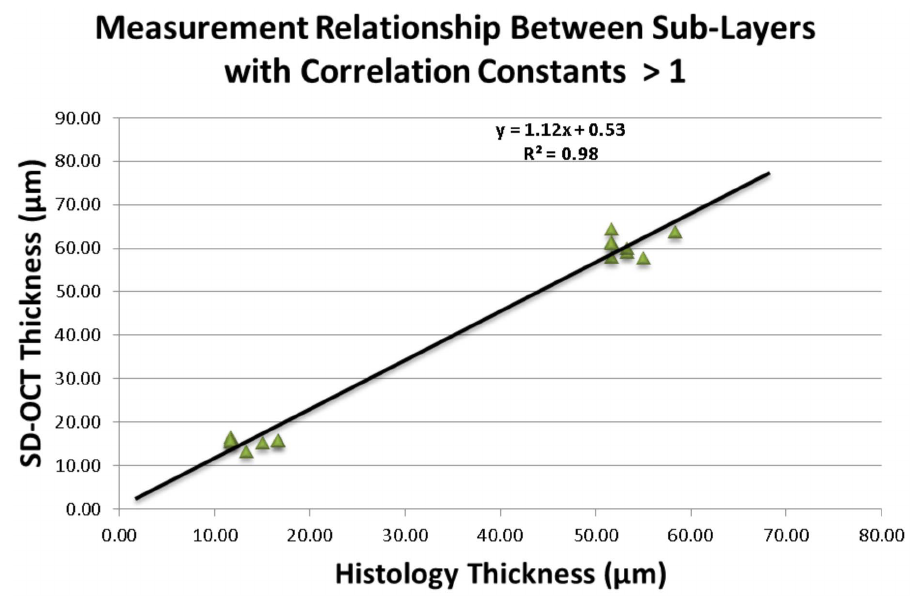
Figure 3. Association between mean SD-OCT and histological thickness with correlation constants . 1. Scatter plot points refer to all observations for outer nuclear layer and retinal nerve fiber layer.